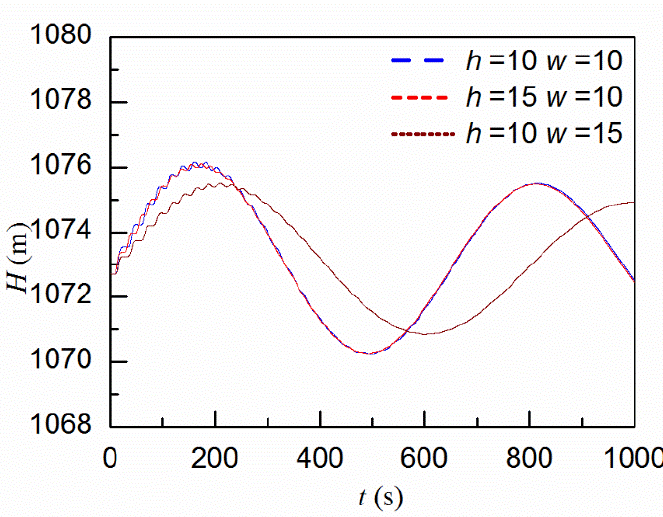
Figure 10. Comparison of the water levels in the sand basin with different sizes of the sand basin ( L 1 = 2400 m).